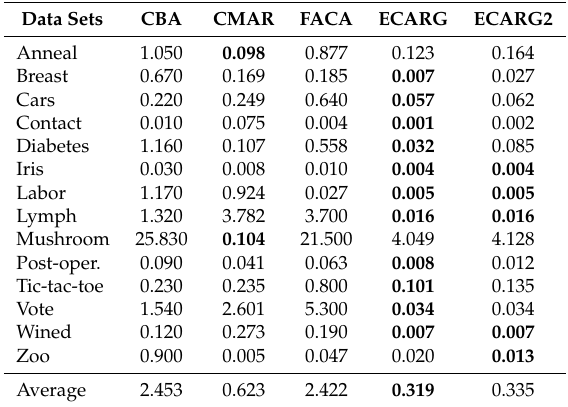
Table 12. The classifier building time in seconds.